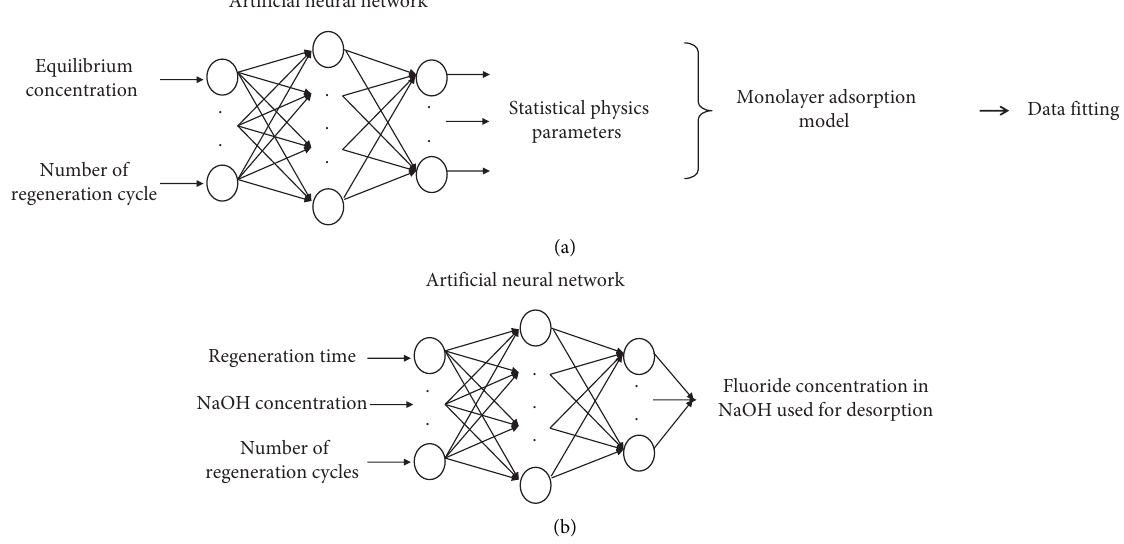
Figure 1: Illustration of ANNs-based approach to model (a) fuoride isotherms of regenerated bone char and (b) fuoride desorption kinetics in NaOH